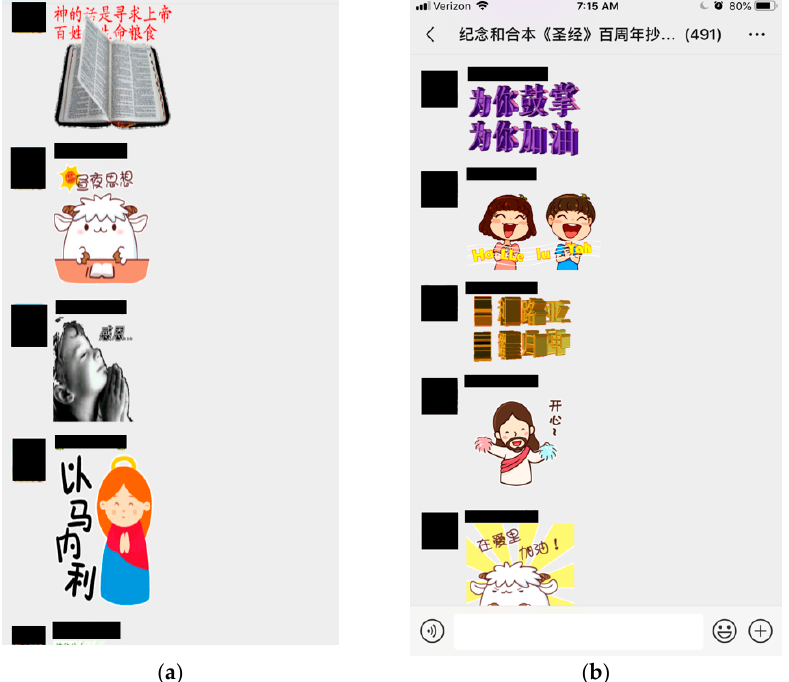
Figure 1. Typical postings in the Protestant WeChat group ( a ) a picture of an open Bible with automatically turning pages that had the words, “God’s words are seeking God; the life and bread of all people”; the second was a cute sheep with blinking eyes sitting at a table with an open book and the words, “pondering [the Bible] day and night;” the third was a black-and-white picture of the side of a Caucasian child’s head with eyes closed and clasped hands with the words, “thankful …”; and the fourth was a cartoon of a female angel in a red and blue dress with orange hair and clasped hands, with the words, “Emmanuel” pulsing next to her. ( b ) “Clapping for you, spurring you on”; two children singing, “Hallelujah”; revolving golden letters saying, “Hallelujah, Glory to God”; Jesus as a cheerleader with pom-poms, “Happy”; sheep with sun rays, “Encouraging you in love.”